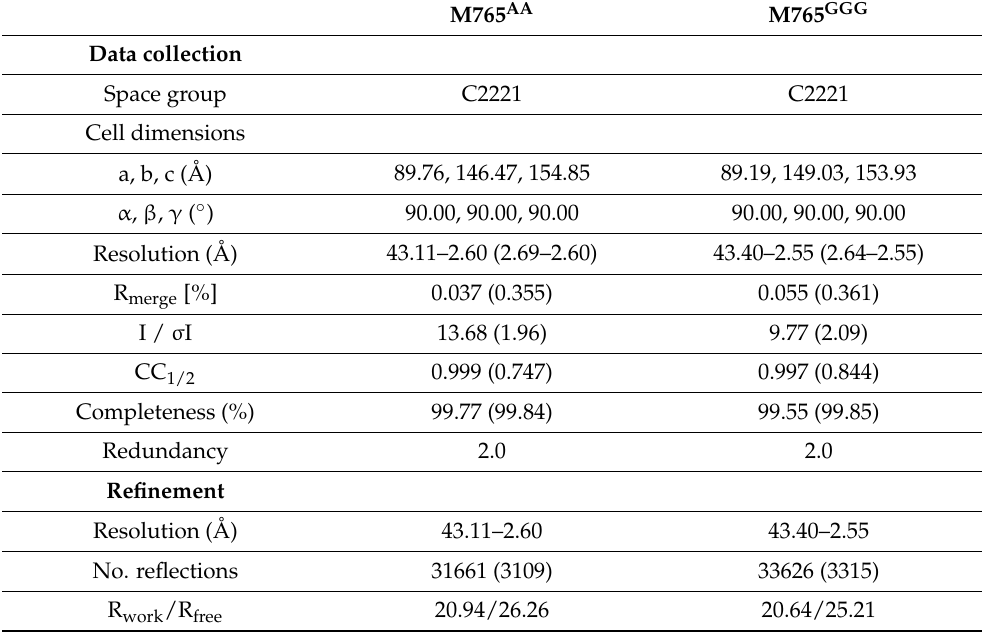
Table 1. X-ray data collection and refinement